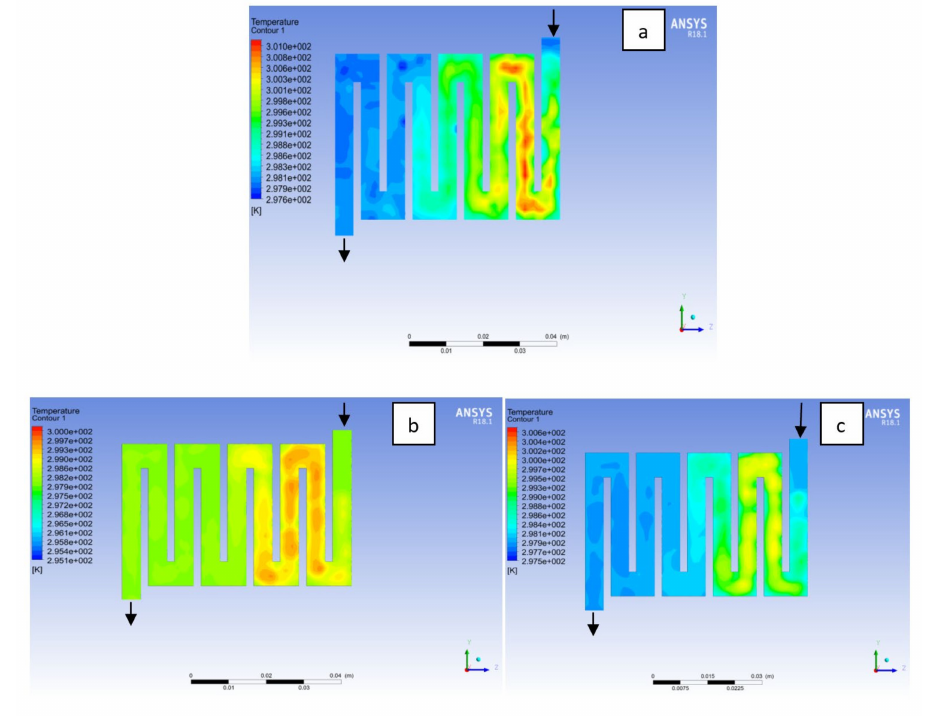
Figure 5. Temperature distribution at the cathode region (GDL/CL) for each material at 298K: ( a ) Aluminum, ( b ) Copper, ( c ) Steel.